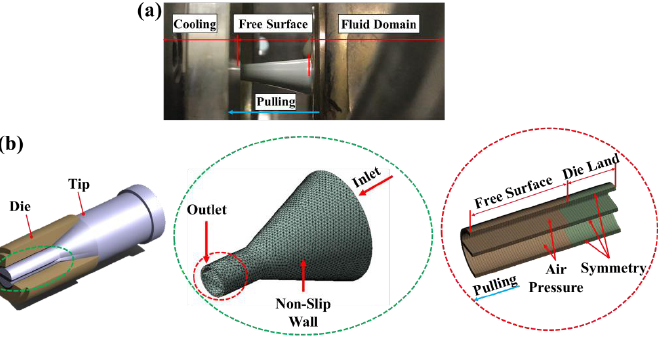
Figure 2. Numerical modeling: ( a ) Photograph of actual extrusion process to be simulated in numerical analysis; and ( b ) image of tip and die, mesh of fluid domain and boundary conditions for numerical analysis.